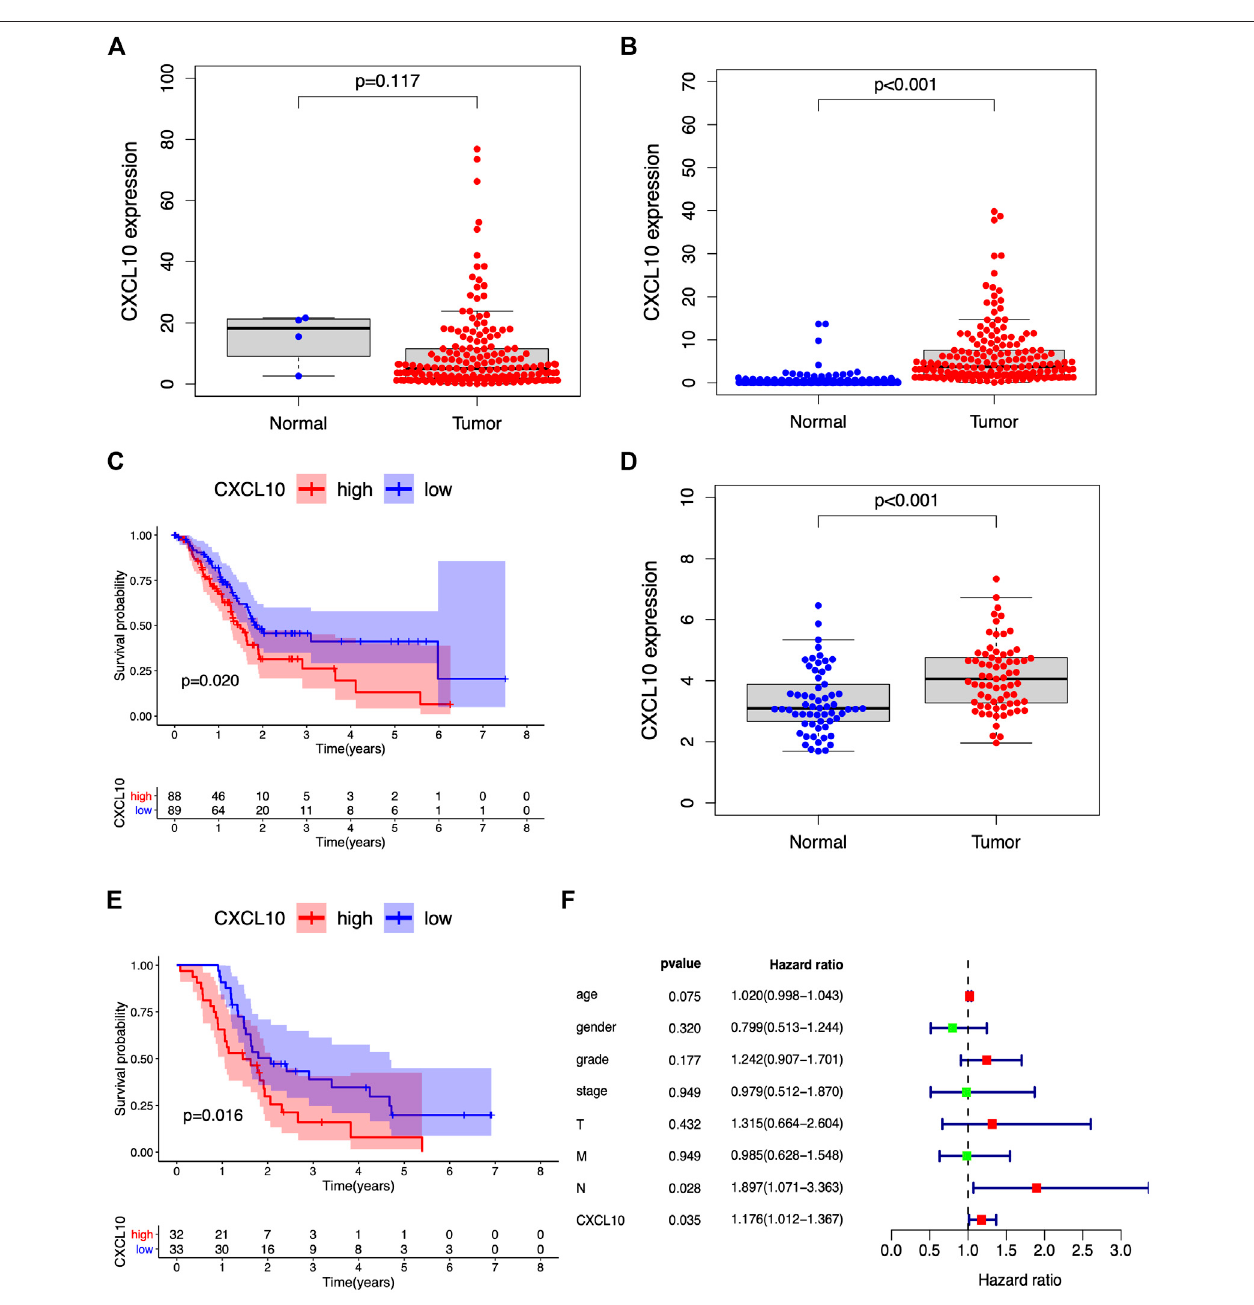
FIGURE6| CXCL10isstronglycorrelatedwithprognosisinPAAD. (A,B) TheexpressionofCXCL10innormalandtumorsamplesfromTCGAdatabaseandGTEx database. (C) Survival analysis for PAAD with high and low CXCL10 expression. (D,E) Validation of CXCL10 expression and survival of PAAD in GSE62452 dataset. (F) Forest plots of multivariate independent prognostic